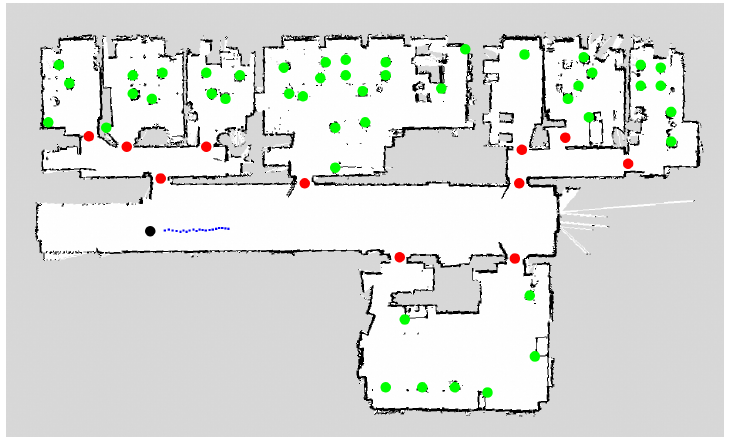
Figure 9. Semantic map obtained with a 3D LiDAR (Velodyne VLP-16) and the approach presented in [32]. Chairs are depicted in green, doors in red and people’s tracked paths in blue. The robot location is given by the black